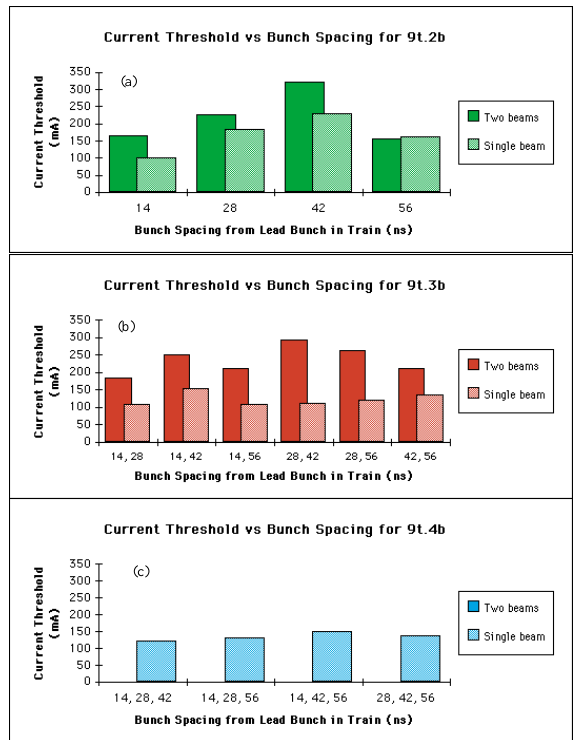
FIG. 20. (Color) The current threshold for the dipole-coupled- bunch instability with nine trains of (a) two bunches per train, (b) three bunches per train, and (c) four bunches per train. These measurements were made with the four copper rf accelerator sections in CESR and during the same period when the streak camera measurements were made.